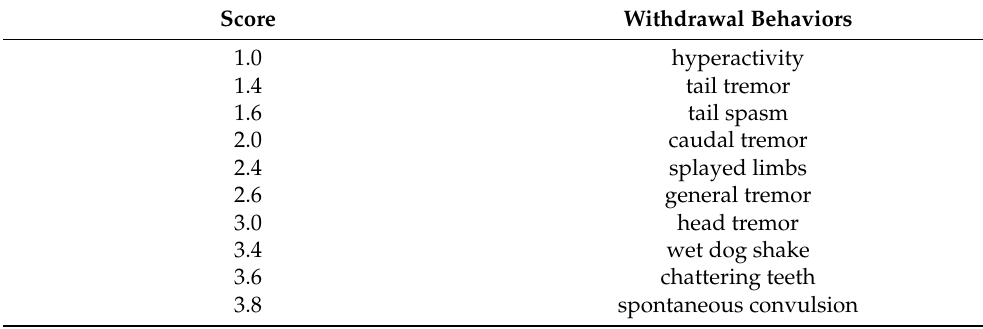
Table 2. Withdrawal Severity